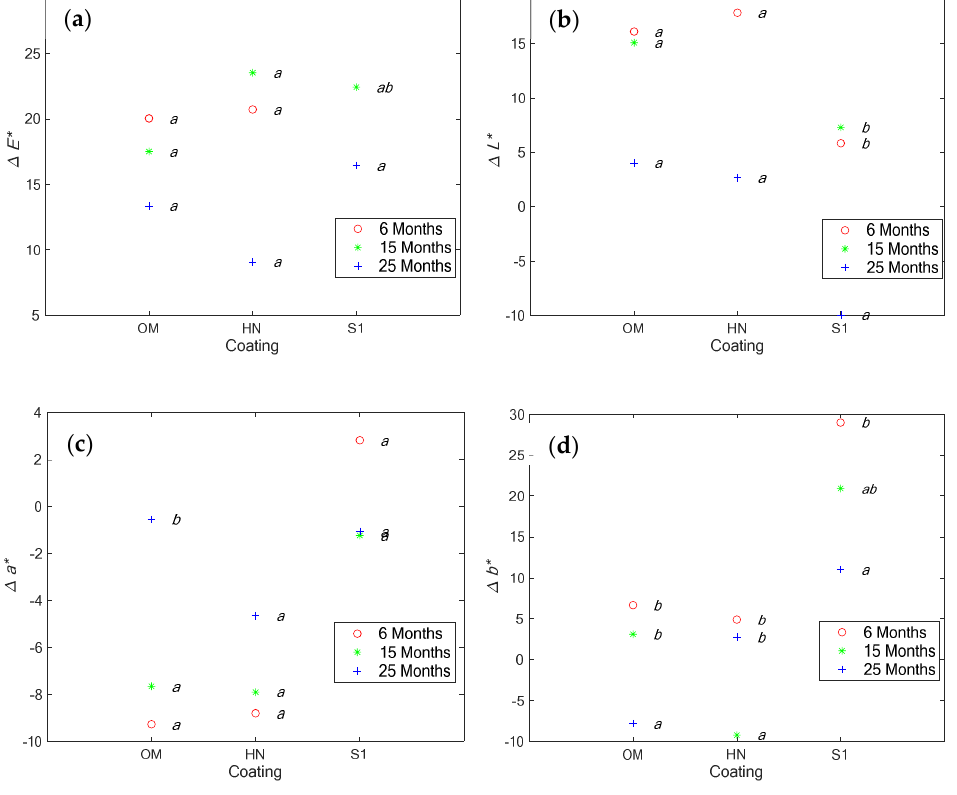
Figure 9. Games–Howell pairwise mean differences in Δ E , Δ L* , Δ a*, and Δ b* for each coating during study for acetylated wood. Values with the same letter indicate that means between intervals do not differ significantly at p < 0.05. ( a ) color change (Δ E) , ( b ) Δ L* , ( c ) Δ a* , ( d ) Δ b*. The most striking differences occurred for surfaces treated with HN between the two locations (Figure 10). For example, Δ E was higher on samples from the Corvallis location, whereas Δ L* and Δ b* were lower in Corvallis at the end of the study for this coating.